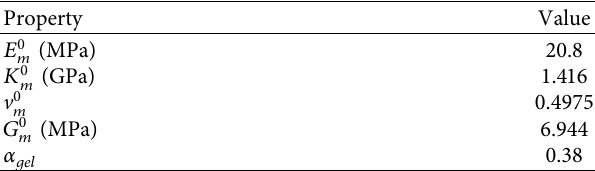
Table 5: Mechanical property of uncured